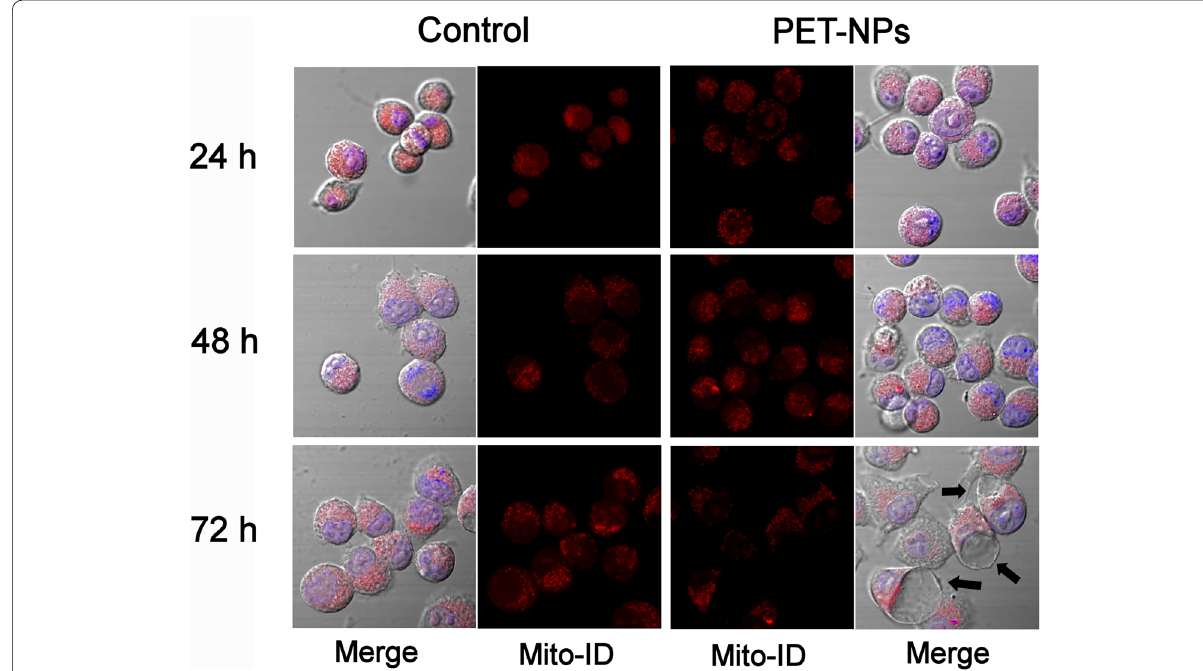
Fig. 4 Mito‑ID confocal images from RAW 264.7 cells incubated in presence of PET‑NPs. Merge image showed the nucleus (Hoechst) and the Mito‑ID signalling for both control and cells incubated with PET‑NPs. Mito‑ID signal have not showed significant difference between control and PET‑NPs. After incubation for 72 h, big lysosomes were easily observed (black